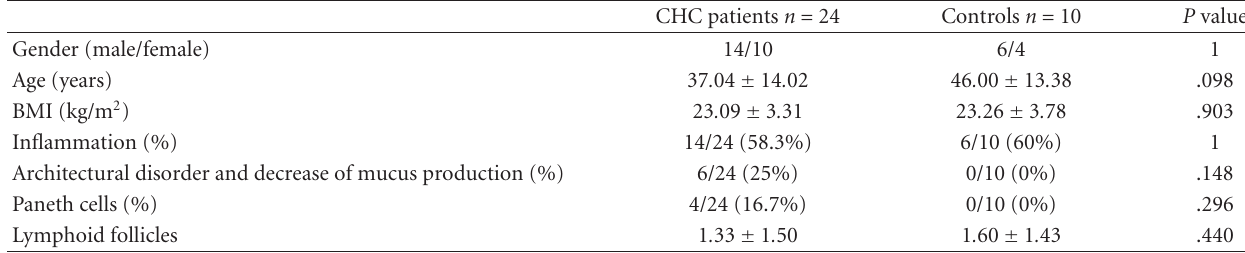
Table 1: Comparison of epidemiological and large intestine histopathology data between untreated CHC patients and controls.